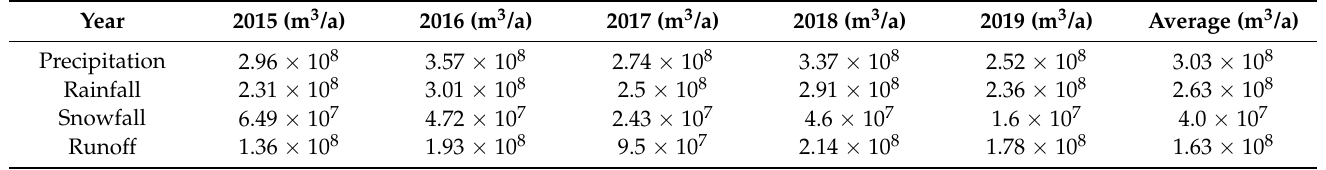
Table 4. Water volume budget upstream Atsuma Bridge